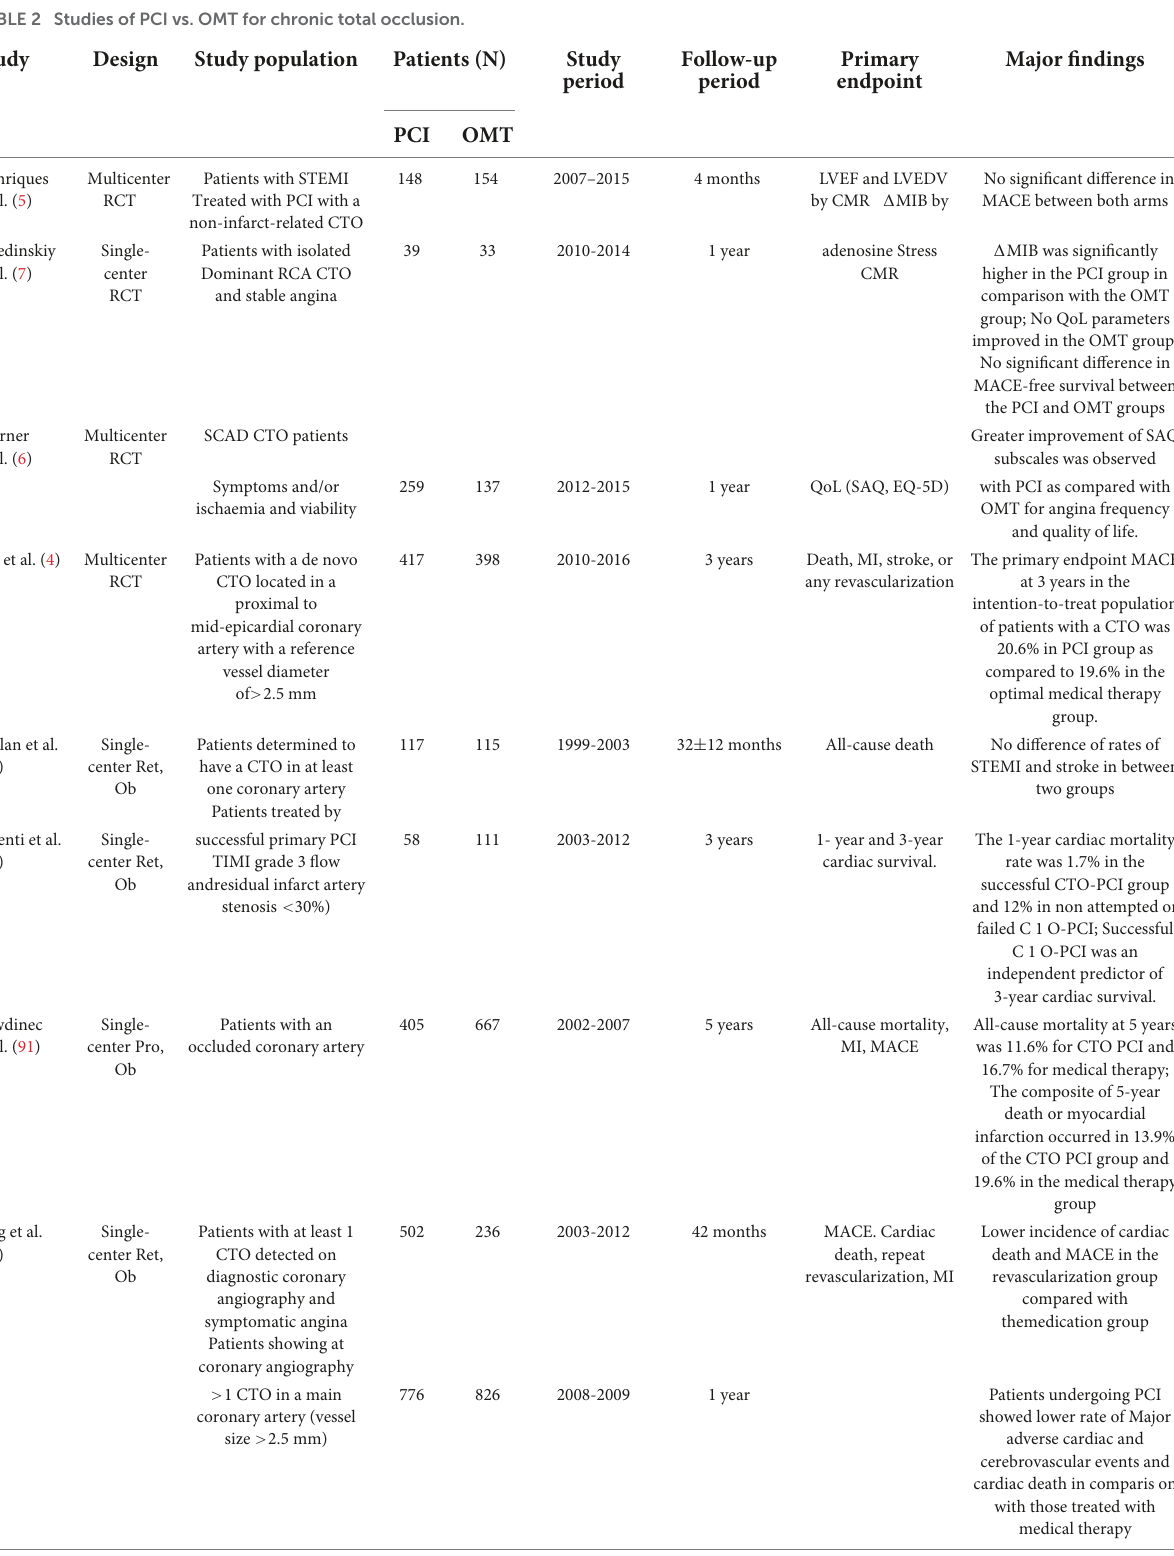
TABLE 2 Studies of PCI vs. OMT for chronic total